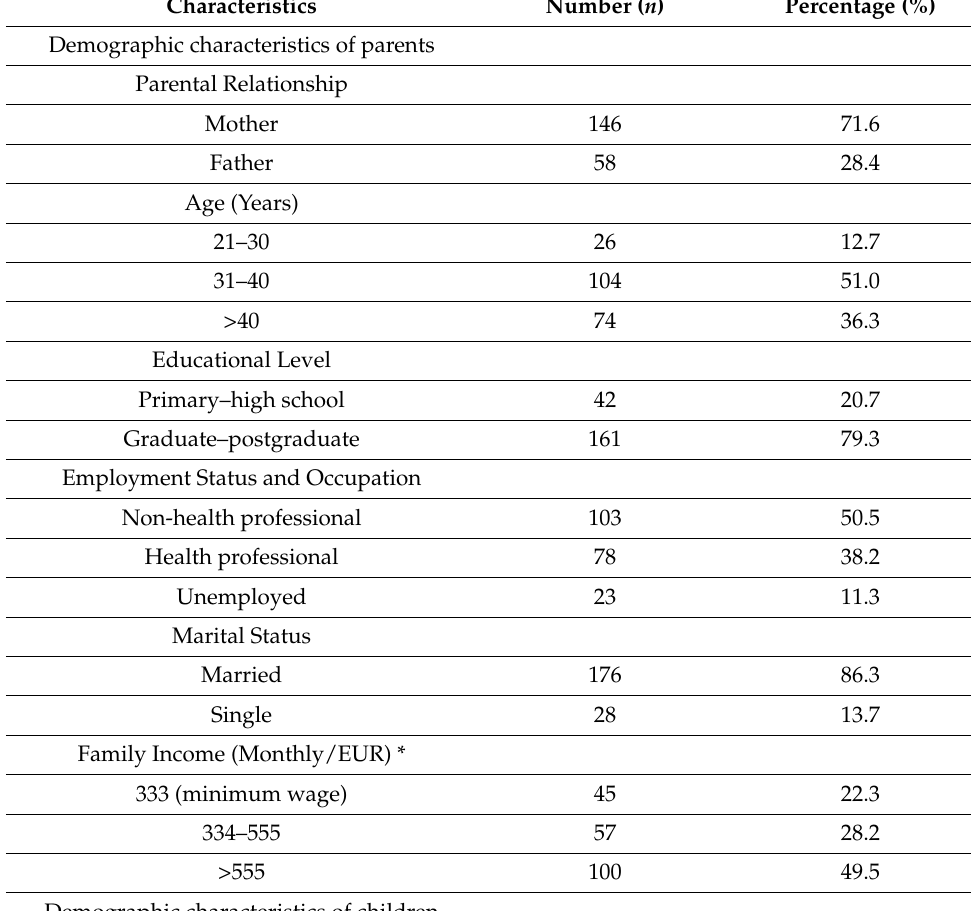
Table 1. Sociodemographic characteristics of parents and